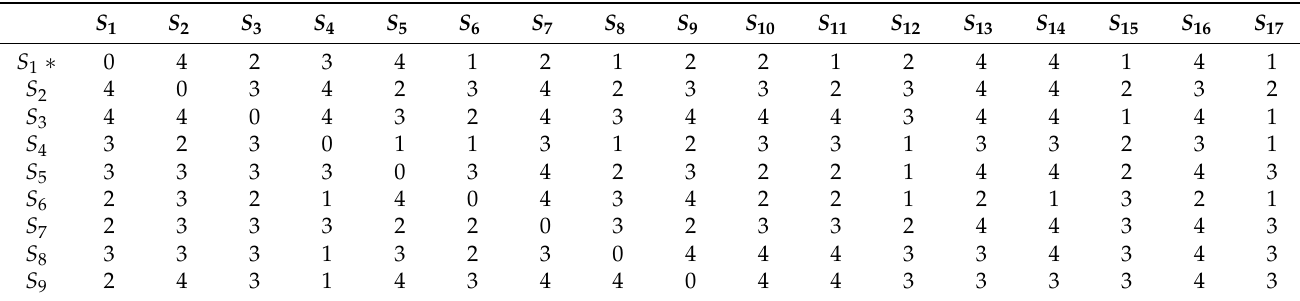
Table 7. Direct-influence matrix A